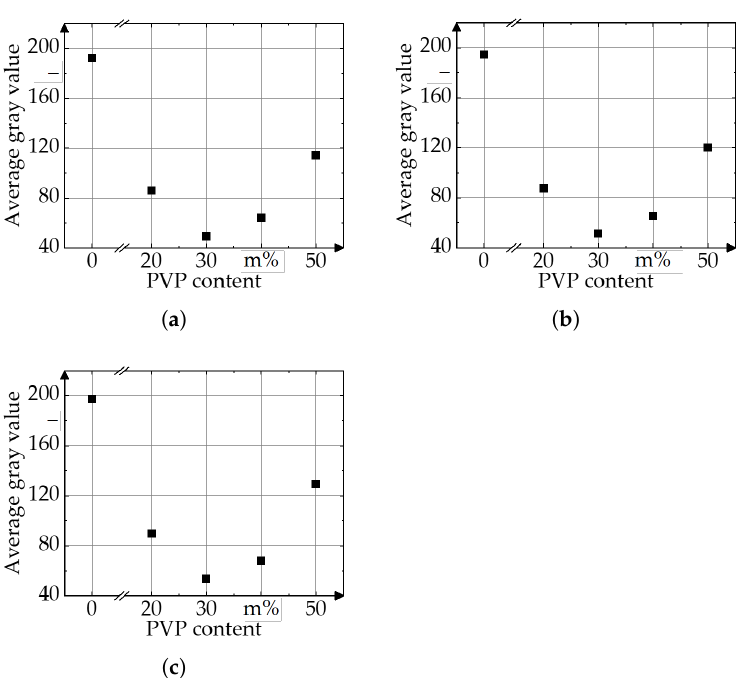
Figure 10. Average gray value of carbon black (CB) dispersions as a function of PVP content at